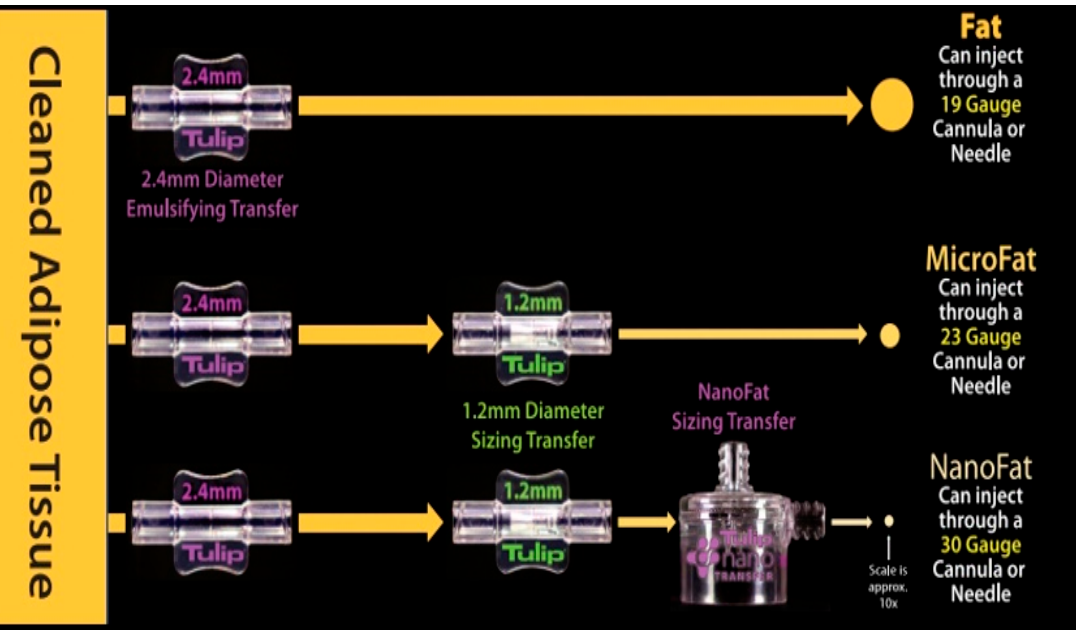
Figure 2. Surgical marking and entry points (indicated as pentagrams) of procedure. Approximately 3.5 to 5 mL of fat per side was injected with a single orifice 18-gauge × 7 cm microinjector cannula (Tulip Medical, San Diego, CA, USA). The quantity of fat injected was based on the morphology of the patient’s face. Microfat was placed to im- prove the nasolabial folds and the cheekbone area through the same entry points used for the macrofat. An amount of 1.5 to 2.5 mL of fat per side was injected with a retrograde fan technique using a 20-gauge × 5 cm single orifice blunt cannula (Tulip Medical, San Diego, CA, USA). Nanofat was injected superficially in the perioral wrinkles and in the vermilion border using a 27-gauge needle. An amount of 2 to 3 mL of nanofat per side was injected using a retrograde linear technique.